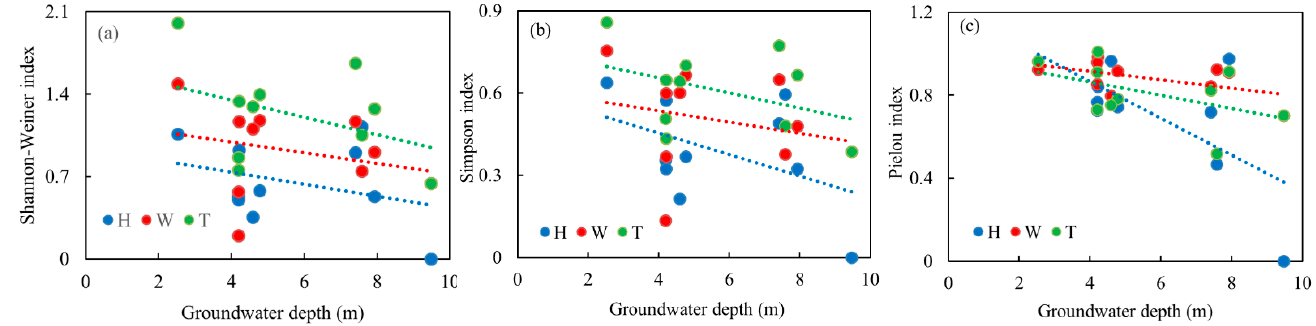
Figure 4. The ( a – c ) show the Shannon–Weiner index, Simpson index, and Pielou index characteristics with groundwater depth, respectively. and “H” refers to herbaceous plants, “W” refers to woody plants, and “T” (Total) refers to both herbaceous and woody plants.